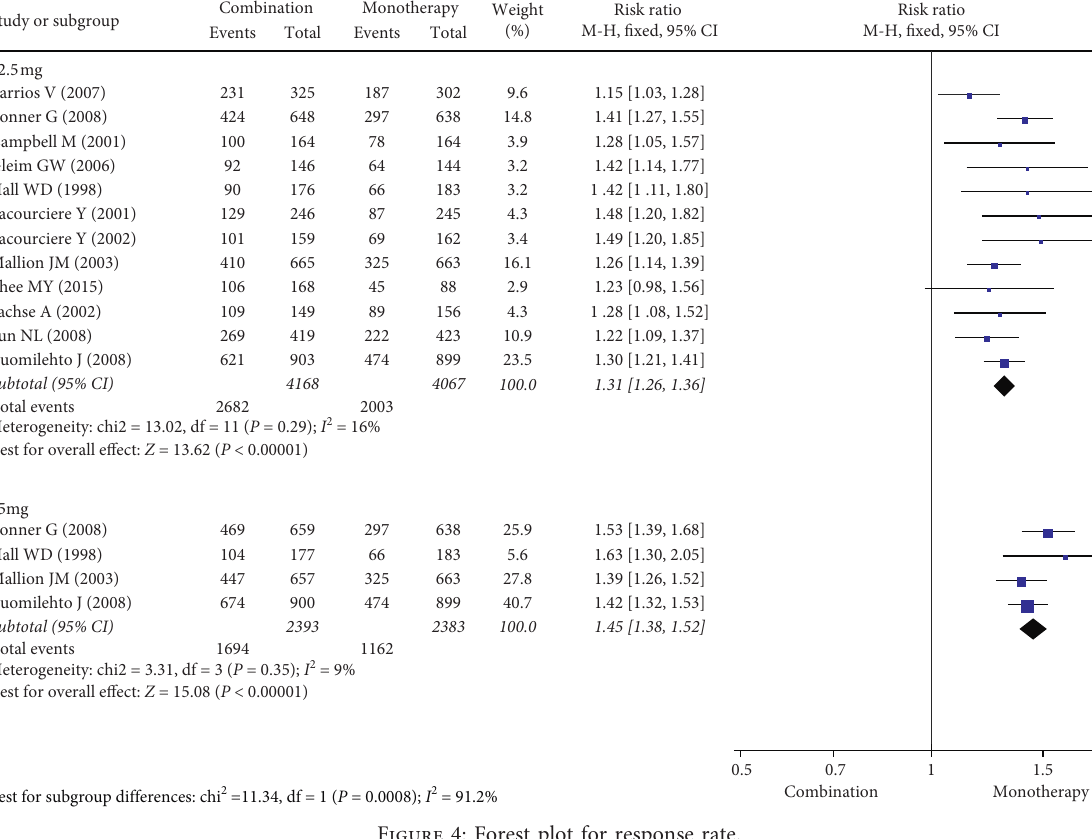
Risk ratio M-H, fixed, 95%